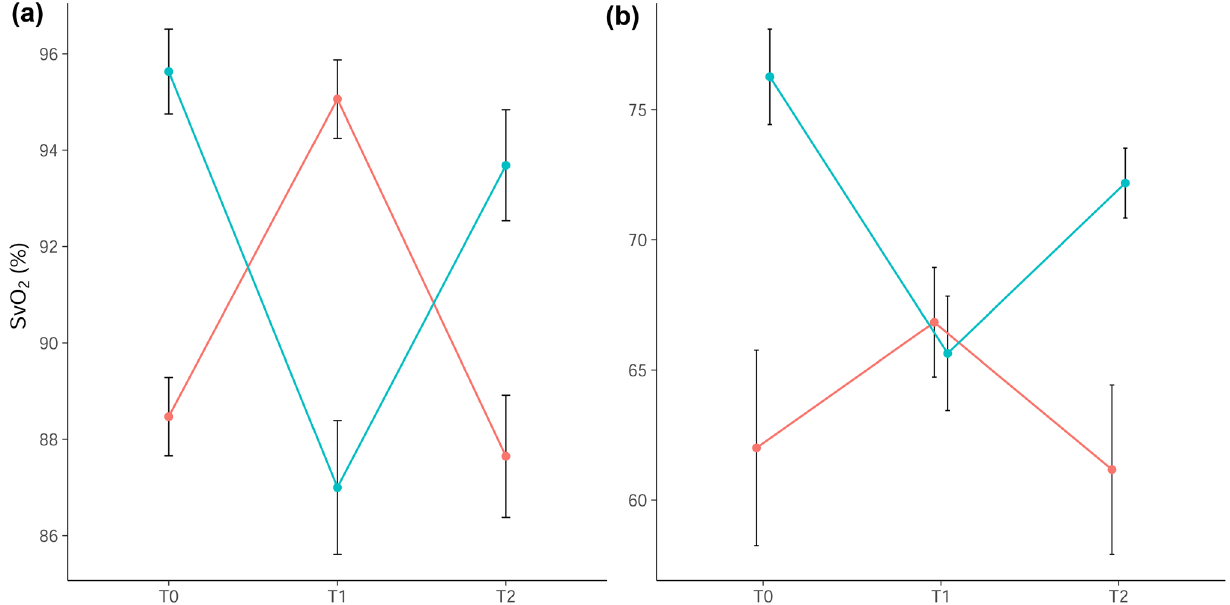
Figure 3. Change of SvO 2 according to different FiO 2 levels in ( a ) on-pump and ( b ) off-pump patients. SvO 2 , mixed venous oxygen saturation; FiO 2 , fraction of inspired oxygen. Created with R: A language and environment for statistical computing. R Foundation for Statistical Computing, Vienna, Austria; https:// www.R- proje ct.